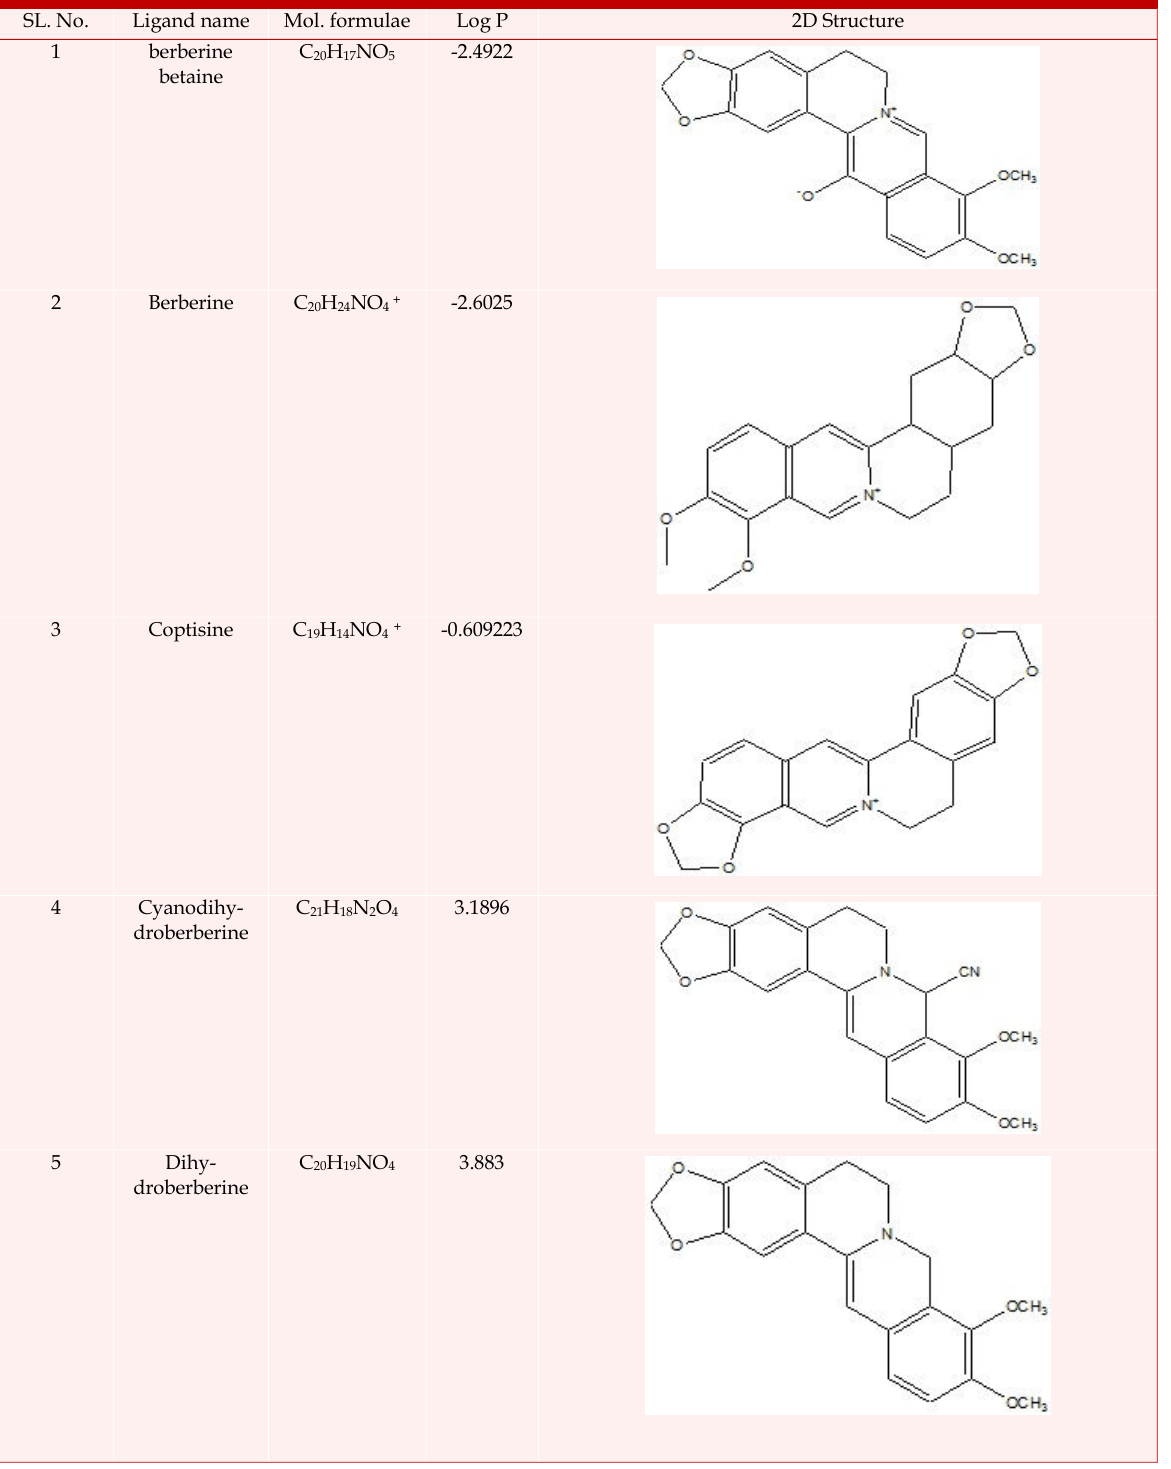
Berberine derivatives along with its chemical properties analyzed using Exome Horizon SL.